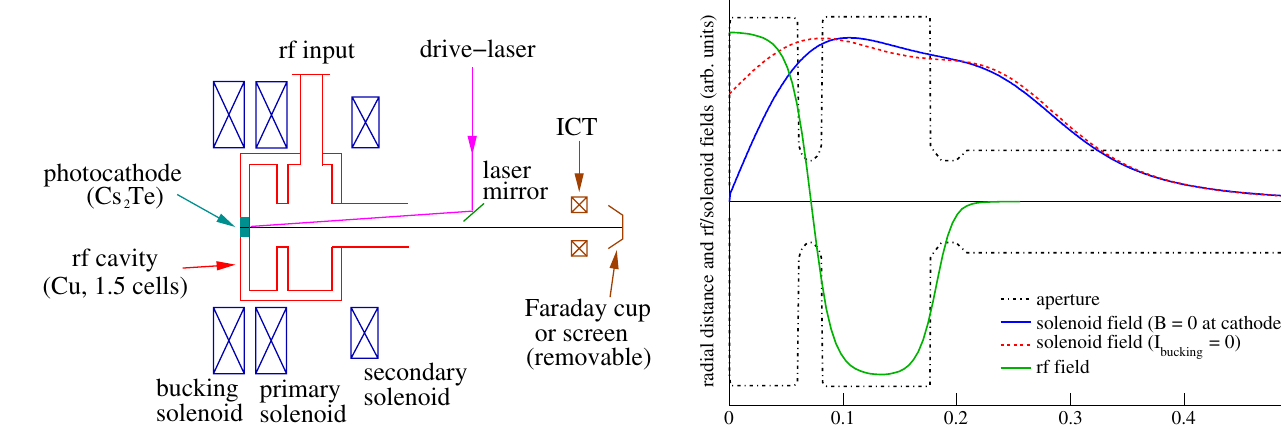
FIG. 2. (Color) Solenoid field, rf field, and simplified aperture for the FNPL gun. As examples, solenoid currents are set as 250 A for the three solenoids for the case of B (cid:1) 0 at cathode. (cid:1) 0 case, 0 A, 162 A, and 260 A are set for the For the I bucking bucking, primary, and secondary solenoids,